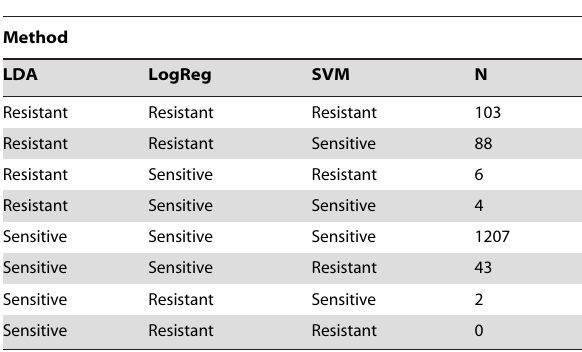
Table 2. Classification as ‘resistant’ or ‘sensitive’ according to the three statistical methods investigated on the entire data set (LDA: Linear Discriminant Analysis; LogReg: Logistic Regression, SVM: Support Vector Machine).